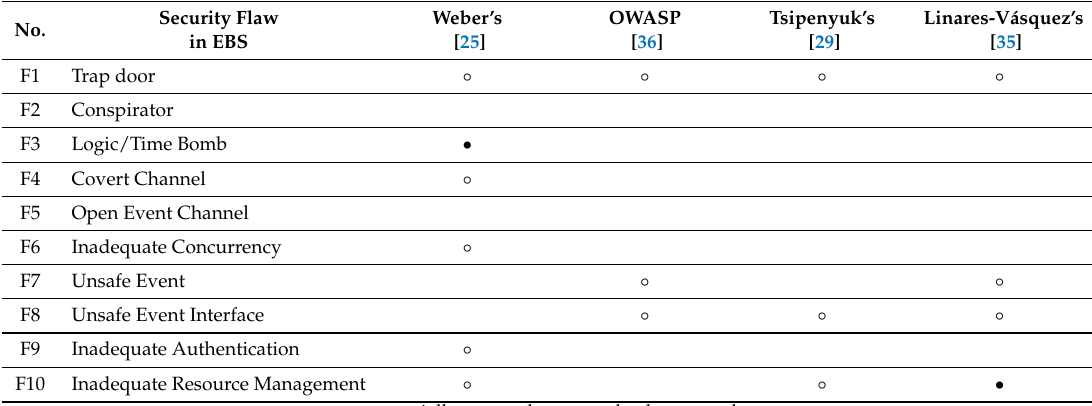
Table 4. Correlation with Existing Security Flaw